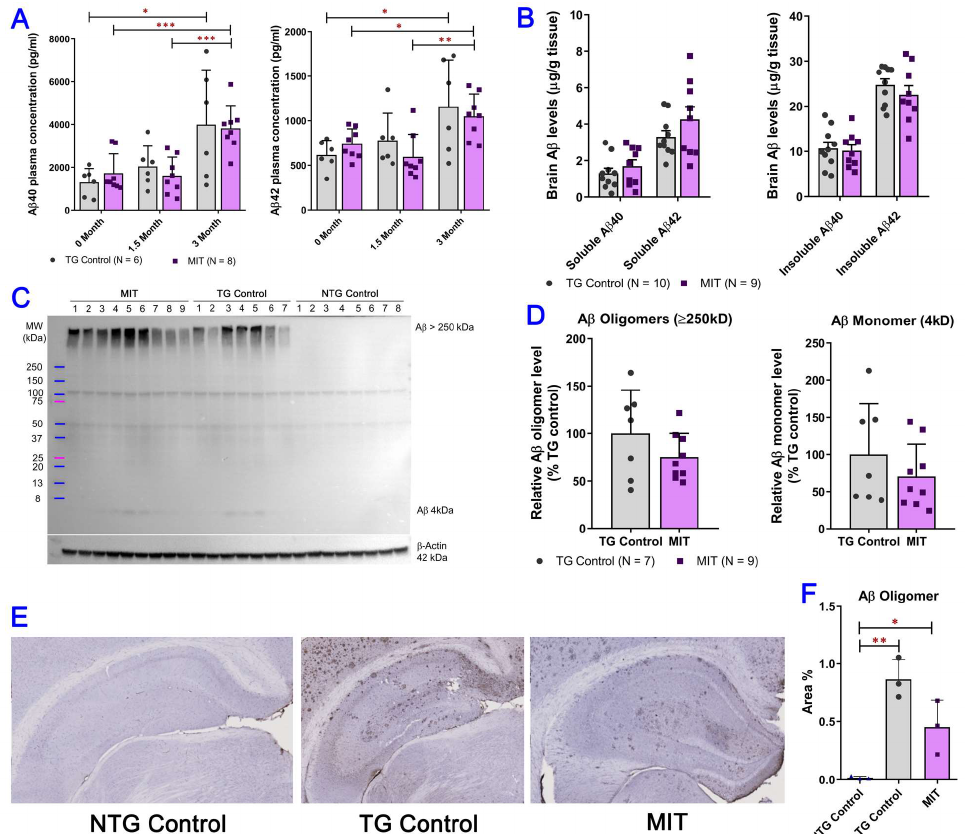
Figure 2. The evaluation of monomeric and oligomeric A β in plasma and brain tissue of APP/PS1 mice after intranasal MIT treatment for 3 months. ( A ) A β 40 and A β 42 levels in the plasma of APP/PS1 mice were evaluated using ELISA. Plasma samples were collected from the APP/PS1 mice at the beginning, in the middle, and after the intranasal treatment course. No significant difference in A β 1-40 and A β 42 plasma levels was found between the TG control (N = 6) and MIT (N = 8) treatment groups ( p > 0.05 using an independent sample t -test). A comparison of plasma soluble A β levels measured at different time points showed that plasma levels of soluble A β in TG control mice measured after the 3-month vehicle treatment were significantly higher than the baseline levels. Soluble A β plasma levels in MIT-treated TG mice measured after the 3-month MIT intranasal treatment were significantly higher than the baseline levels and those measured after the 1.5-month treatment. * p < 0.05, ** p < 0.01, and *** p < 0.001 compared with measurement at 3 months after the start of the treatment using one-way ANOVA with a Tukey’s post hoc multiple comparison test. ( B ) Soluble and insoluble A β 40 and A β 42 peptide levels in TG control (N = 10) and MIC-treated TG (N = 9) brain tissues were evaluated using ELISA. Brain tissue samples were collected from the NTG mice treated with vehicle control and the TG mice treated with either vehicle control or MIT once daily for 3 months. ( C ) Western blotting analysis of oligomeric (MW = >250 kD) and monomeric (MW = 4 kD) A β in the brain tissue of MIT-treated (N = 9), TG control (N = 7), and NTG control (N = 8) mice. Neither oligomeric nor monomeric A β was detectable by Western blotting in NTG control brain tissues. ( D ) Densitometric analysis of aggregated and monomeric A β levels in the brains of aged MIT-treated TG mice and not-treated mice. Detection of β -actin was used to ensure equal sample loading per line. No significant difference in A β was found between the TG control and MIT treatment groups. All data are presented as mean ± SD. ( E ) Coronal slices of the left cerebral hemisphere from MIT-treated, NTG, and TG control mice. Representative A β oligomer staining images of brain sections. ( F ), quantification of IHC staining of A β . IHC results are presented as the percentage of A β oligomer staining positive tissue area per field in the brain. No statistically significant differences in the A β oligomeric isoform were found between the MIT-treated and the TG control